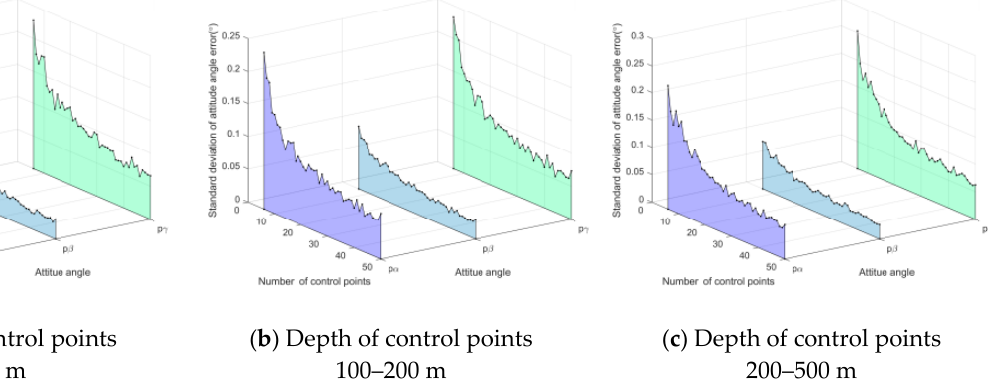
Figure 12. SDAAE vs. number of control points.